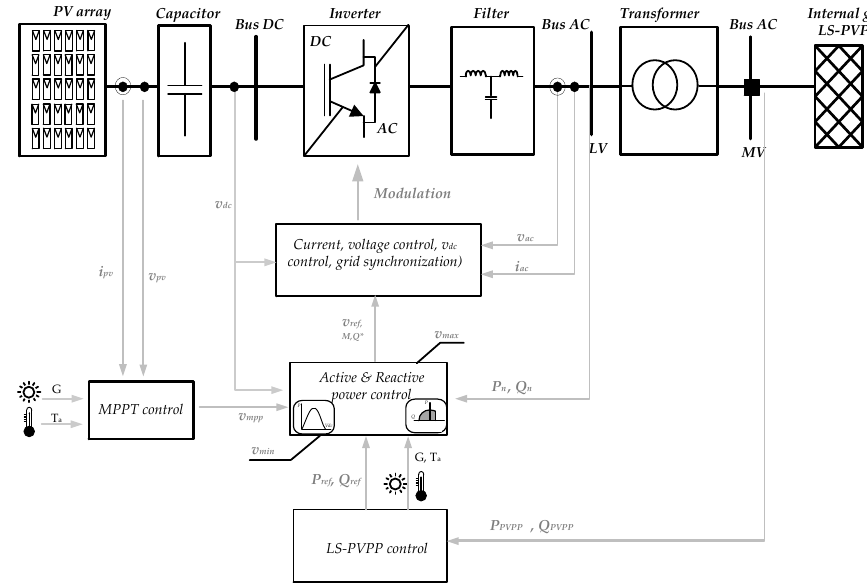
Figure 6. General control of a PV